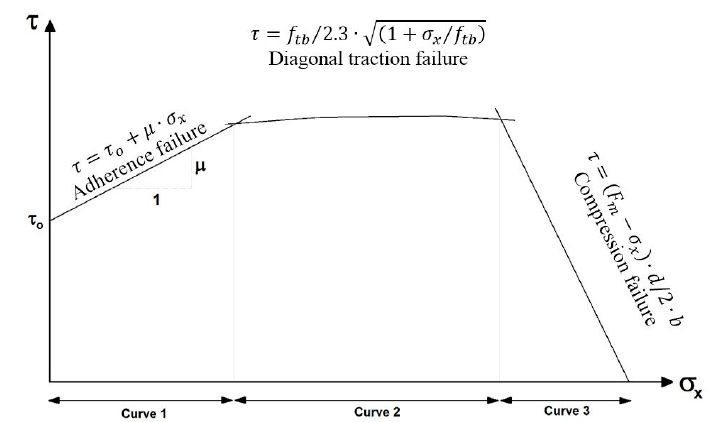
Figure 3. Failure envelope for masonry design.